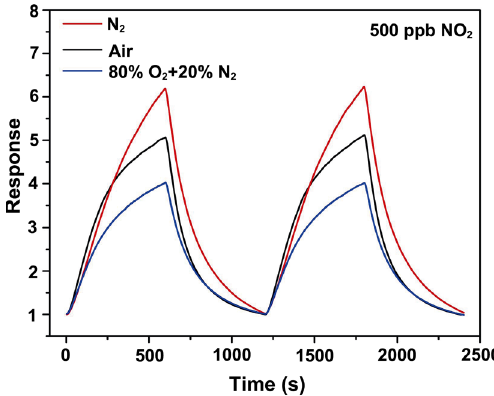
Fig. 10 Response curves of the WO 3 nanomesh sensor to NO 2 (500 ppb) in nitrogen balance and air balance, and 80% O 2 +20% N 2 background at 160 ℃